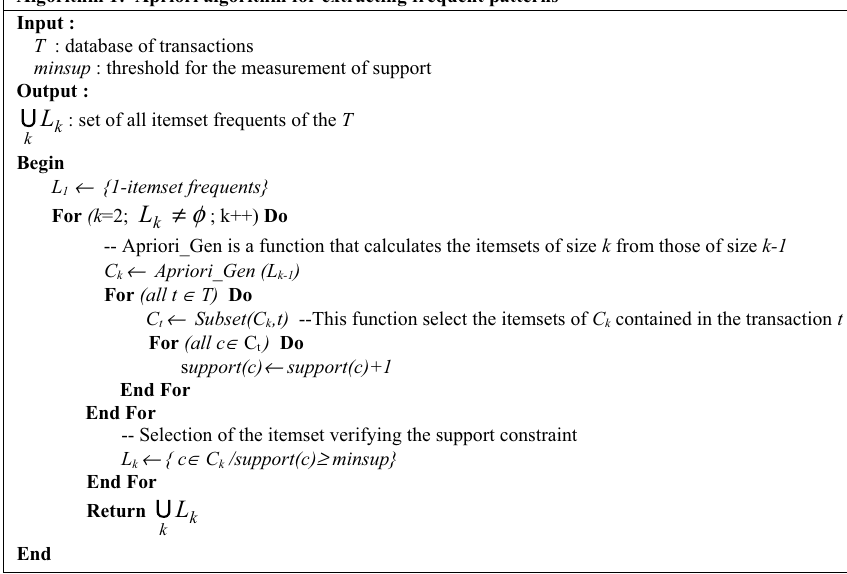
Algorithm 1: Apriori algorithm for extracting frequent